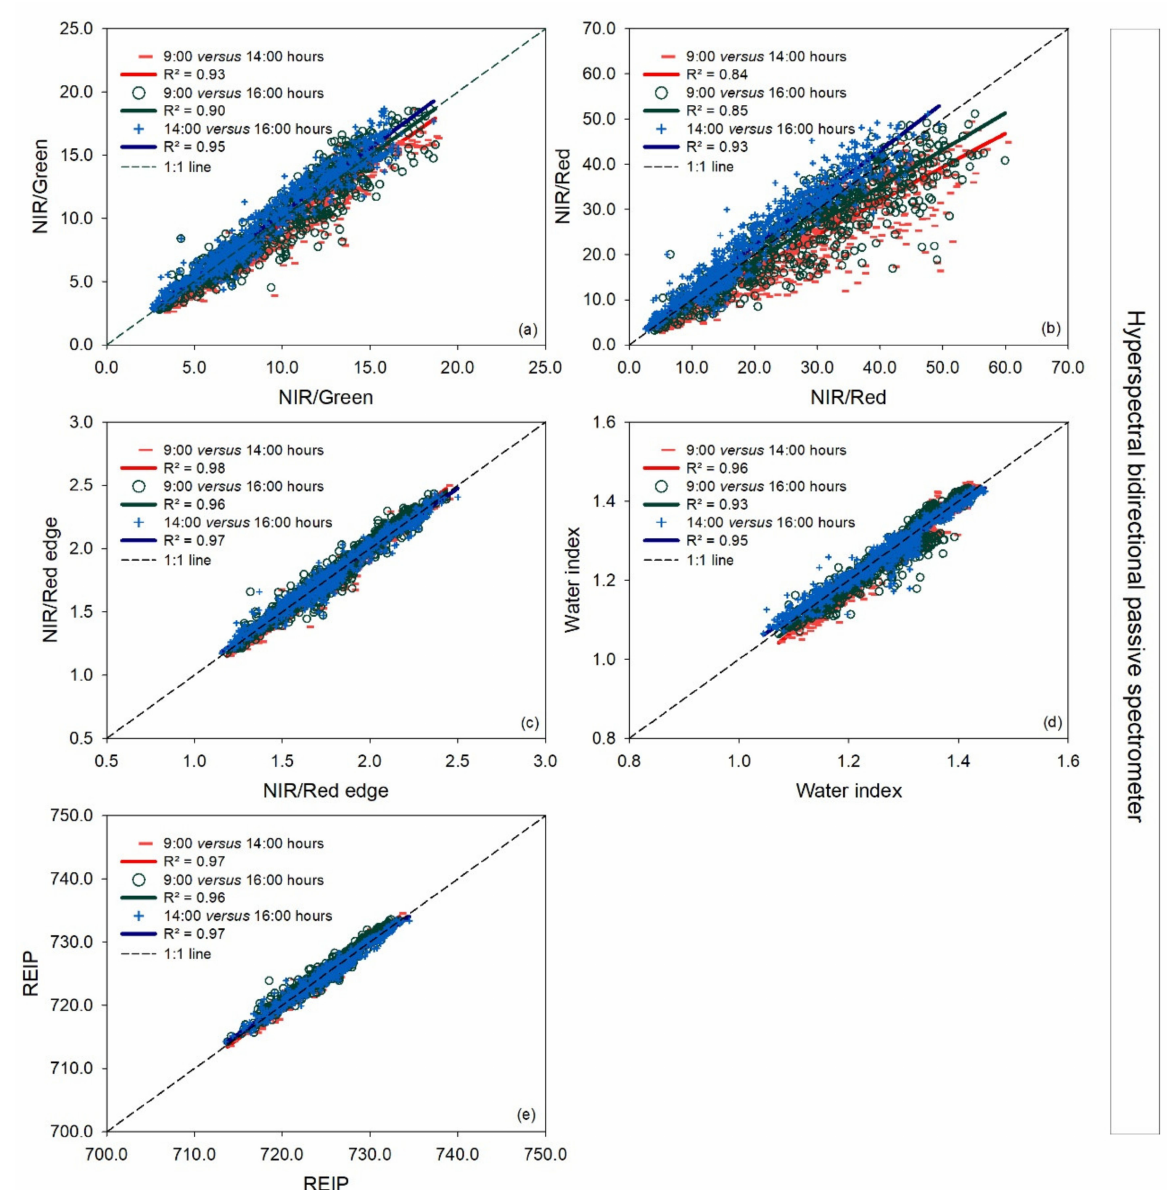
Figure 4. Linear regressions between paired measurement times (9:00 versus 14:00 h, 9:00 versus 16:00 h, and 14:00 versus 16:00 h) for each vegetation index measured with a vehicle-carried hyperspectral bidirectional spectrometer for the three measurement dates together. R 2 : coefficient of determination. The dashed line represents the 1:1 line. In the pairwise comparison, the earlier time is indicated on the x-axis and the later time on the y-axis ( a – e ). Of the vegetation indices measured with the handheld hyperspectral bidirectional HandySpec Field sensor, there was no deviation observed for the NIR/Green, NIR/Red edge ratios, and the water index REIP. The NDVI and GNDVI index was lower at 14:00 and 16:00 h relative to at 9:00 h at values below 0.70. The NIR/Red ratio showed an apparent deviation at 16:00 h compared to 9:00 h at values higher than 25 (Figure